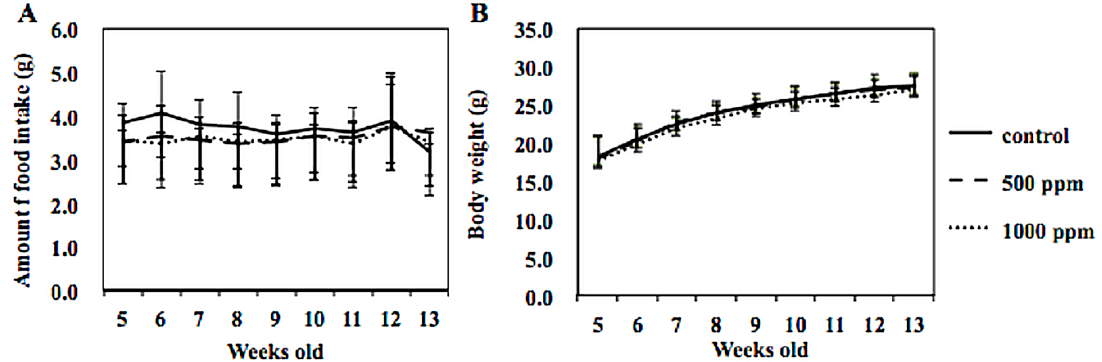
Figure 3. Amount of food intake and body weight changed throughout the experimental period. Amount of food intake / mouse / day ( A ) and body weight of each mouse ( B ) were measured weekly. Table 1. The number of intestinal polyps / mouse in Min mice treated with or without NZ-419. Dose No. of Mice